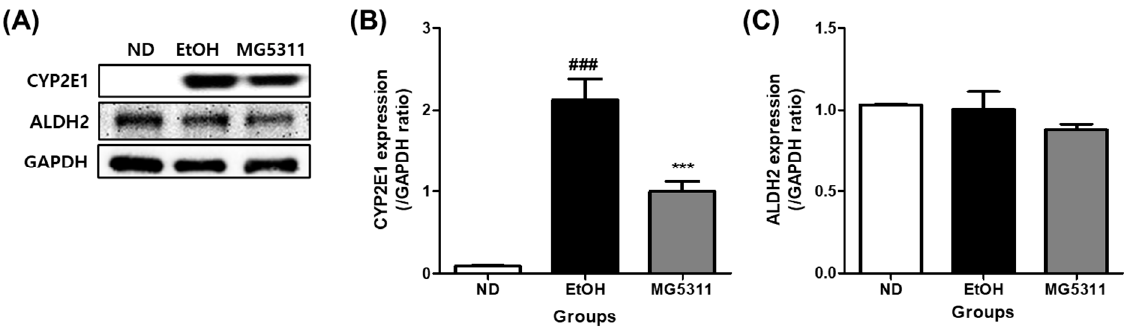
Figure 3. Effect of L. brevis MG5311 on protein expression of ethanol metabolism enzymes in liver tissues of ethanol-fed mice. ( A ) representative Western blot; ( B ) cytochrome P450 2E1 (CYP2E1); and ( C ) aldehyde dehydrogenase 2 (ALDH2). Data are presented as mean ± SD ( n = 3). Significance was analyzed by Dunnett’s test. ### p < 0.001 vs. ND group. *** p < 0.001 vs. EtOH group. ND; normal diet, EtOH; ethanol diet, MG5311; ethanol diet- L. brevis MG5311.